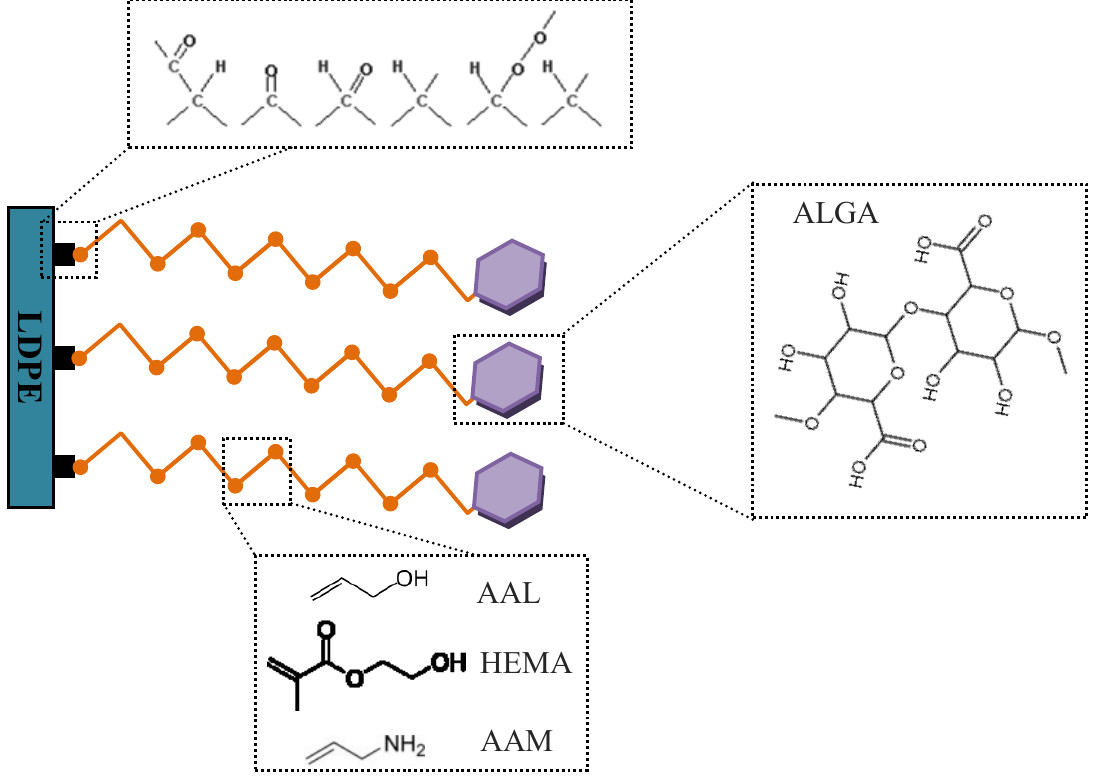
Figure 4. Alginic acid molecules coated onto polymeric brush spacer grown on plasma activated low-density polyethylene (LDPE)